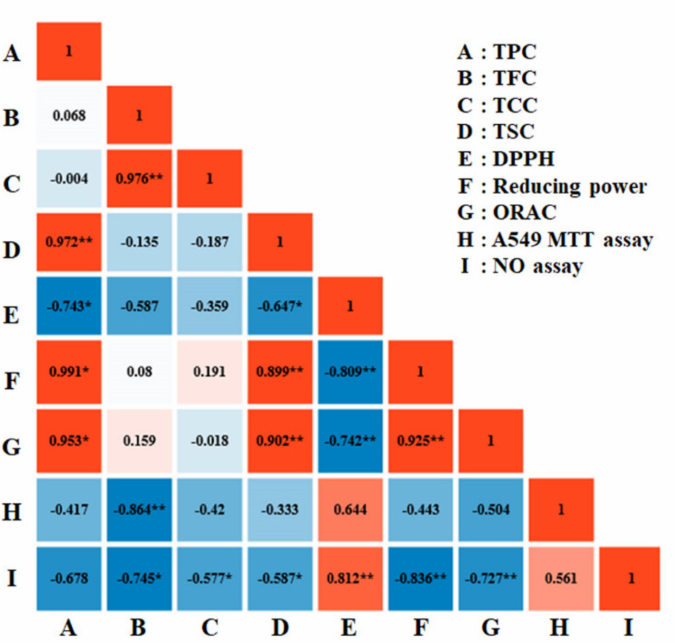
Figure 5. Pearson correlation coefficient analysis of the phytochemical contents versus the antioxidant, anticancer, and anti-inflammatory activities of R . rugosa extracts. TPC, total phenolic content; TFC, total flavonoid content; TCC, total carotenoid content; TSC, total saponin content. *, p < 0.05, **, p <